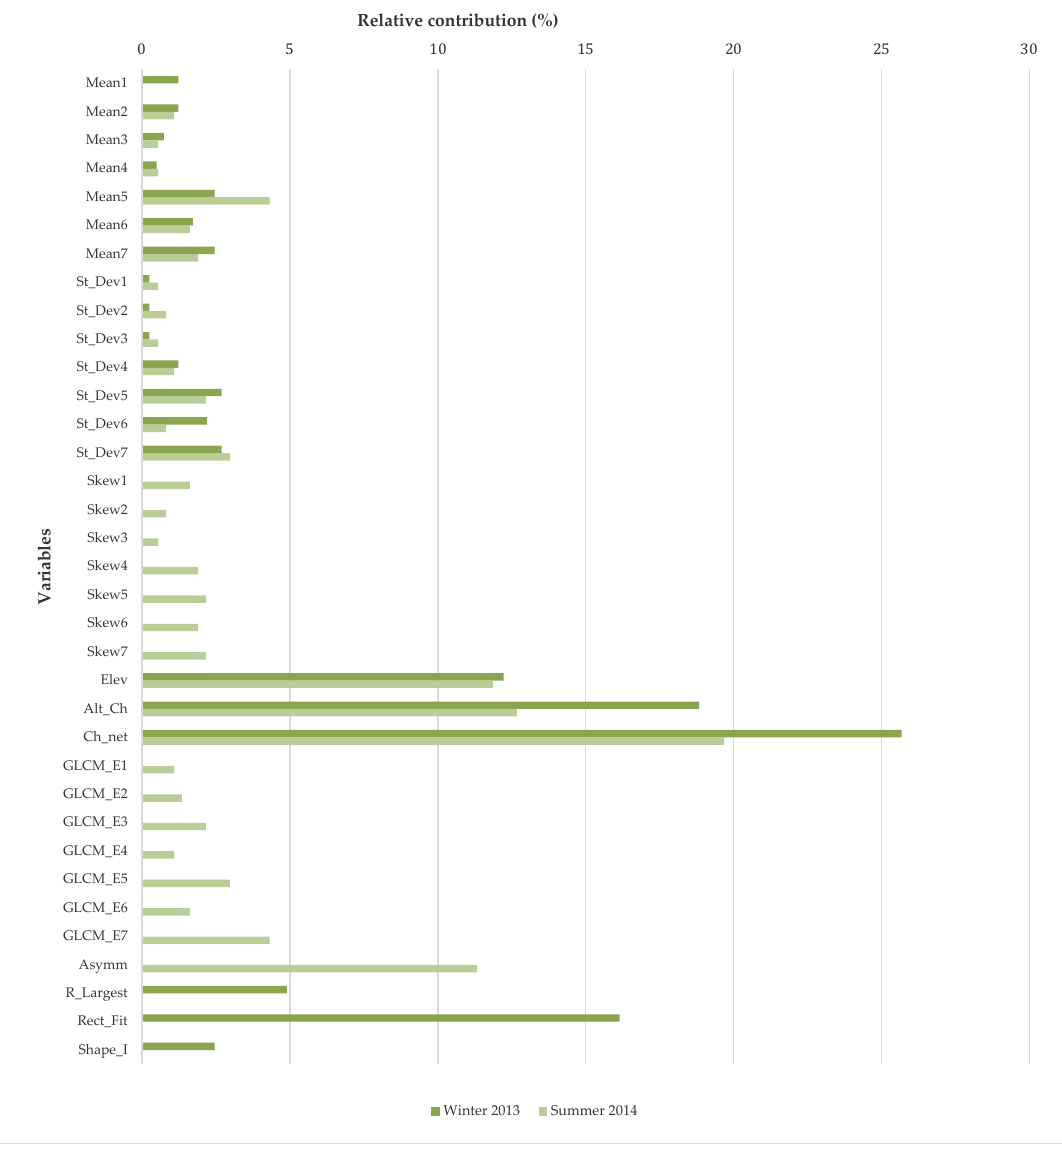
Figure 6. Relative contribution of advanced object-based and topographic variables for DT classifications performed with winter 2013 and summer 2014 Landsat 8 images. Variables described in Tables 2 and 3.